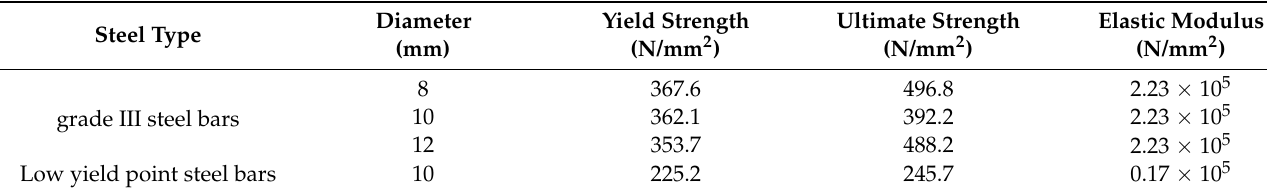
Table 3. Mechanical properties of steel.